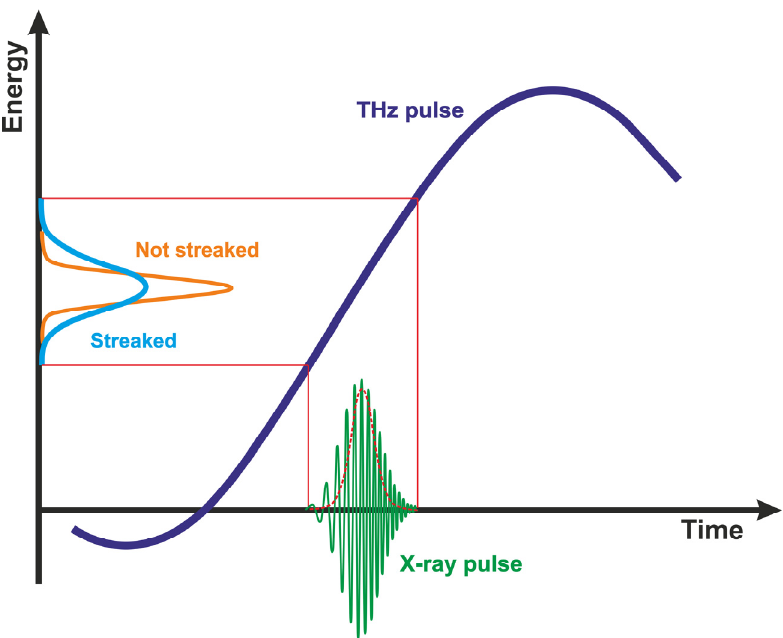
Figure 2. The streaking of an X-ray-induced photoelectron pulse in a THz vector potential. The X-ray pulse temporal profile is encoded in the energy spectrum of the measured photoelectron spectrum.